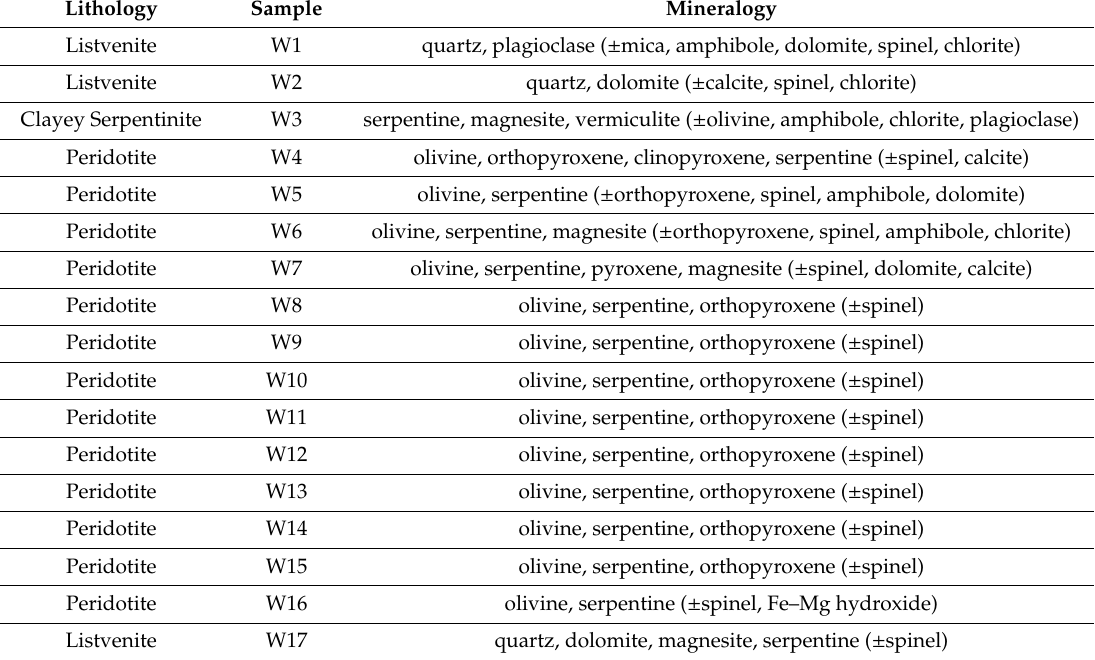
Table 1. Mineralogical assemblage of the sampled rocks based on optical microscopy study. Lithology